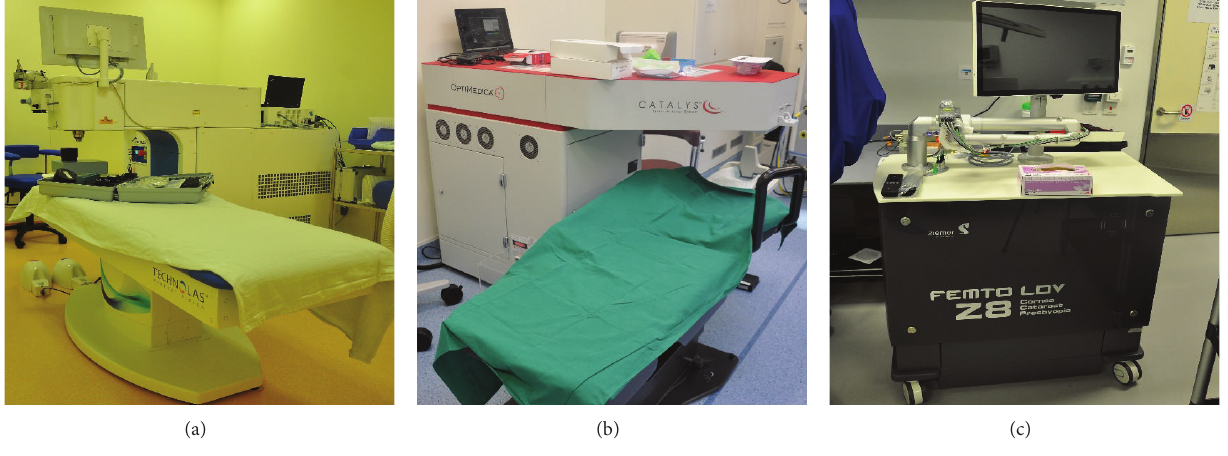
Figure 1: Three different femtosecond laser platforms. Victus (a), Catalys (b), and LDV Z8